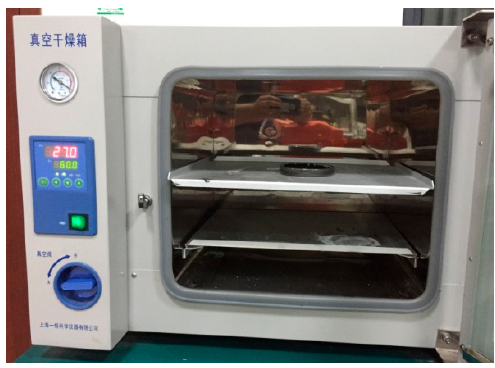
Figure 1. Vacuum drying chamber with a preset temperature.